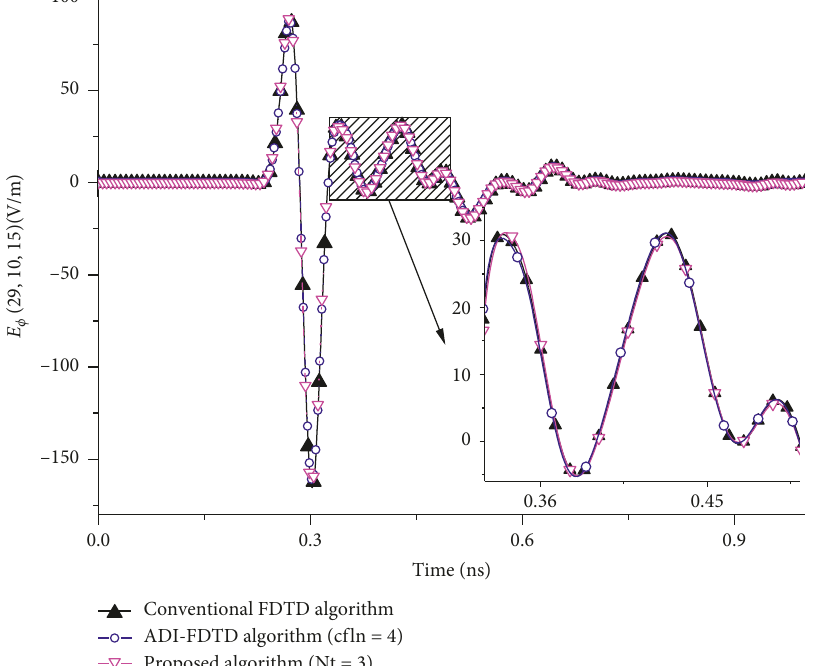
Figure 12: Computational results of E algorithm.